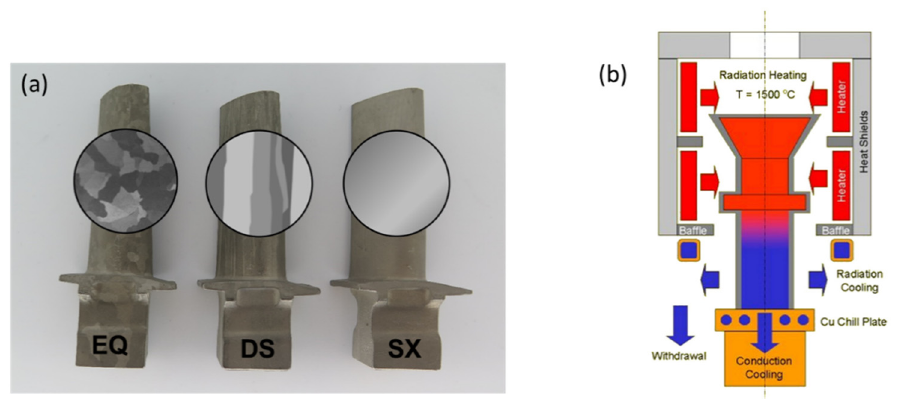
Figure 6. ( a ) Turbine blades with different grain structures according to the casting process, ( b ) schematic diagram of Bridgman casting system.